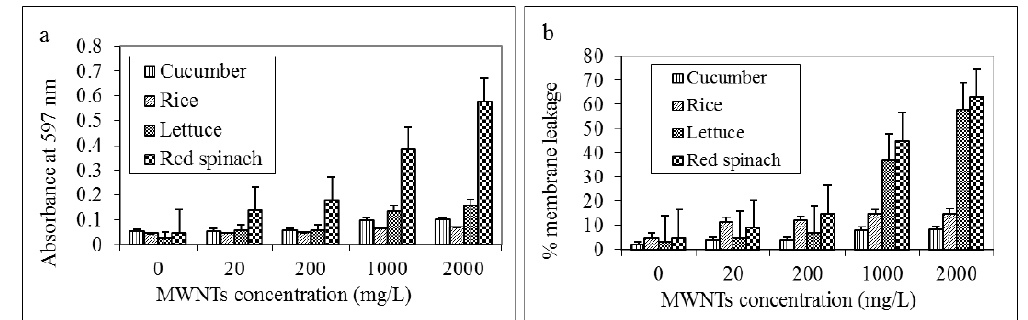
Figure 4. Dose dependency of ( a ) cell death and ( b ) membrane integrity caused by 15-day exposure to MWNTs at 0, 20, 200, 1000, or 2000 mg/L in red spinach, lettuce, rice, and cucumber roots. Error bars represent standard deviation of the mean ( n = 3). Reproduced with permission from reference [16], Copyright 2012,